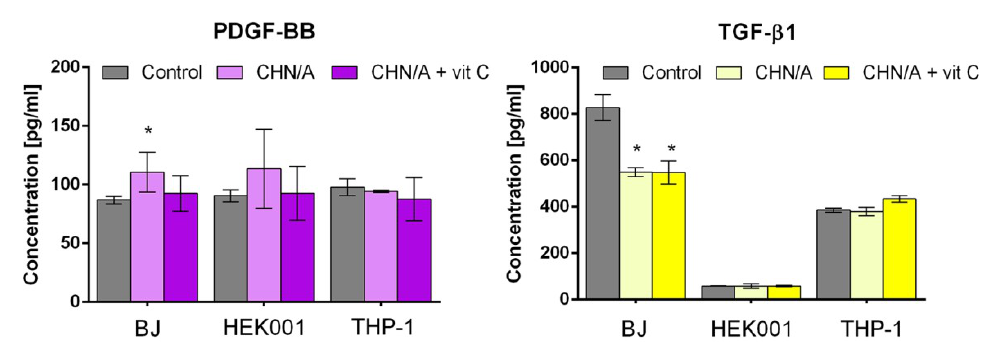
Figure 6. The level of growth factors (GFs) produced by human fibroblasts, keratinocytes, and culturedfor4daysonthesurfaceofthefilmsassessedbyELISAs(control—cellsculturedontheglasscoverslip, macrophages cultured for 4 days on the surface of the films assessed by ELISAs (control—cells BJ—human skin fibroblasts, HEK001—human epidermal keratinocytes, THP-1—human macrophages cultured on the glass coverslip, BJ—human skin fibroblasts, HEK001—human epidermal differentiated from THP-1 cell line, * statistically significant results compared to the control cells; n = keratinocytes, THP-1—human macrophages differentiated from THP-1 cell line, * statistically